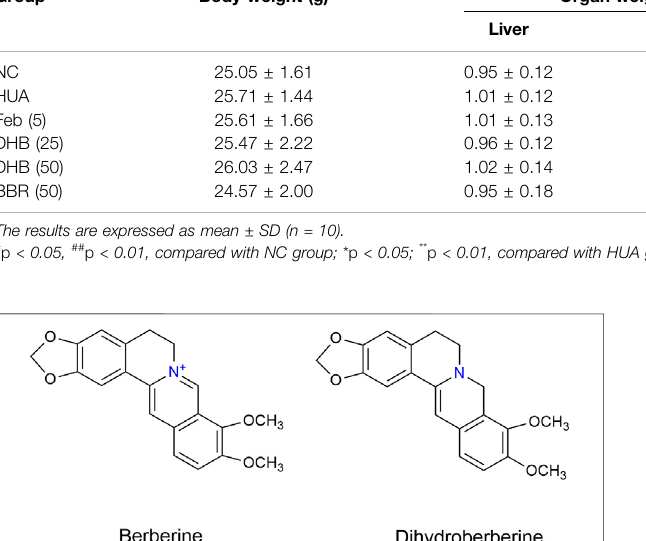
TABLE 2 | Effect of DHB on body weight, organ weight and organ index. Group Body weight (g)